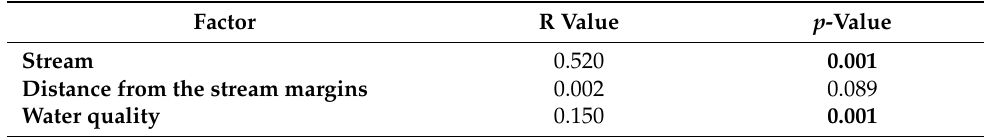
Table 2. ANOSIM—changes in understory species composition related to the site (stream), distance from the margins, and water quality group. Factor R Value p -Value